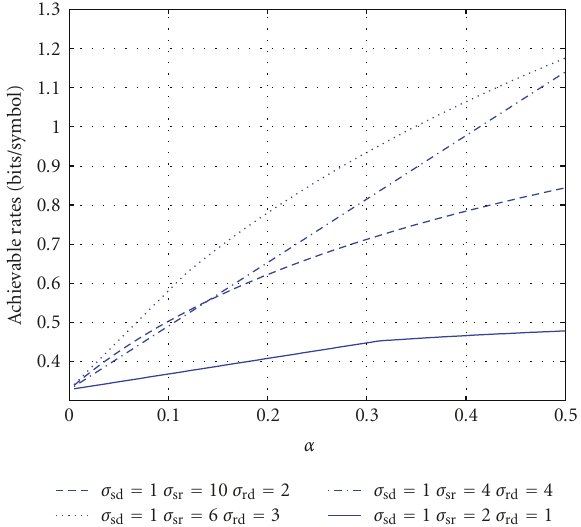
Figure 8: Overlapped DF with repetition coding achievable rate versus α when P s = P r = 0 . 5, δ s = δ r = 0 . 1, and m = 50.